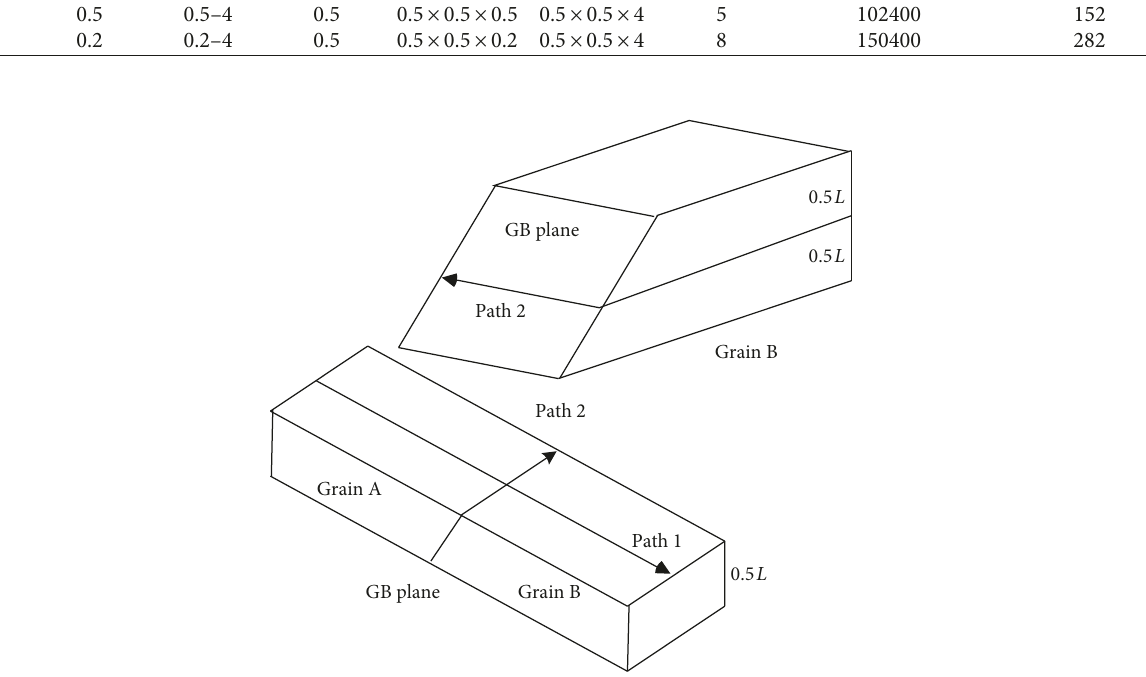
Figure 6: Locations of the two paths to measure stress.